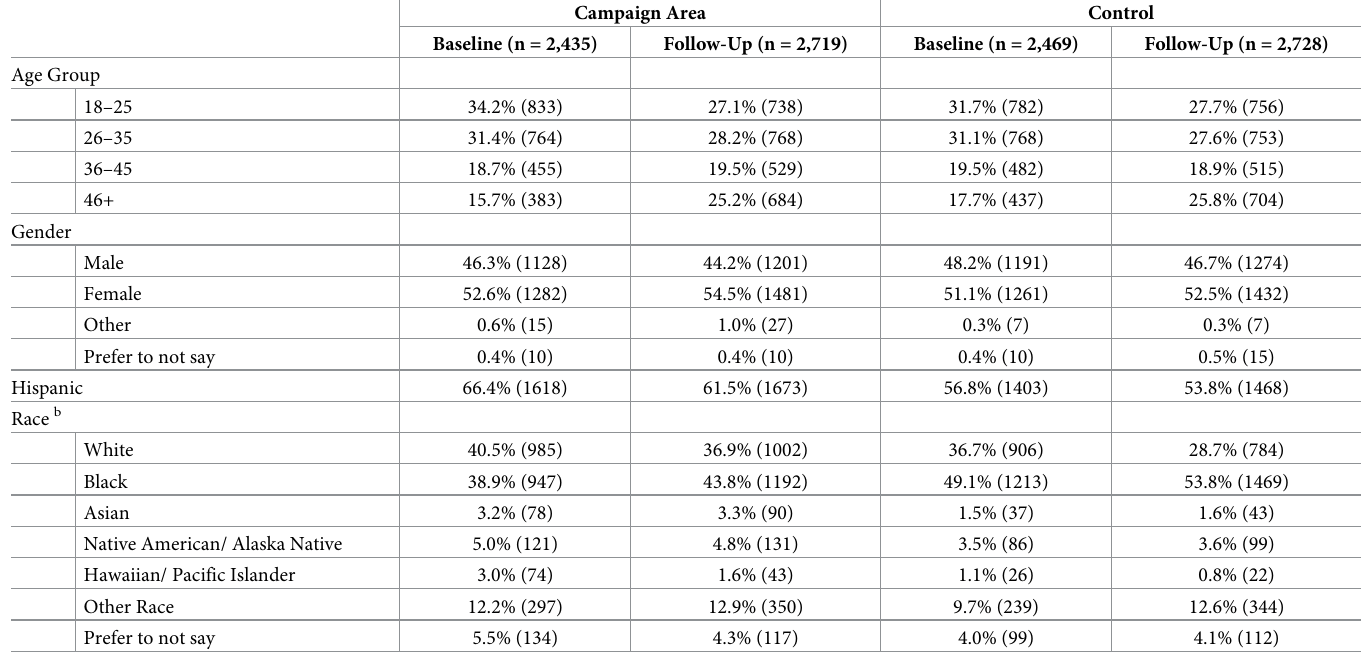
Table 1. Demographics at baseline and follow-up, campaign area vs. control a